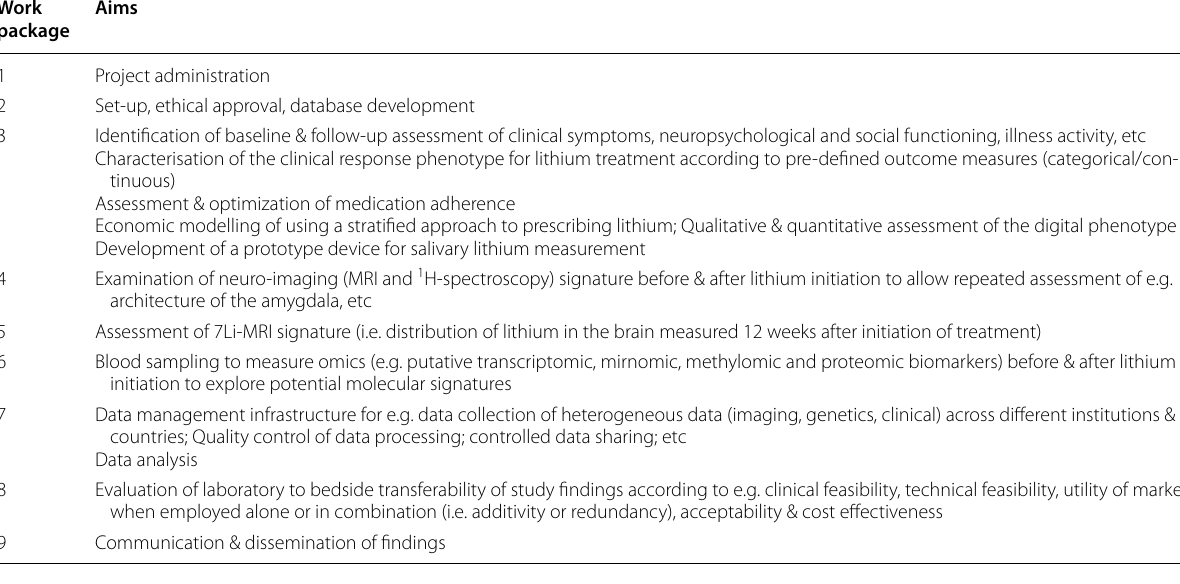
Table 2 Overview of the R‑LiNK work packages Work